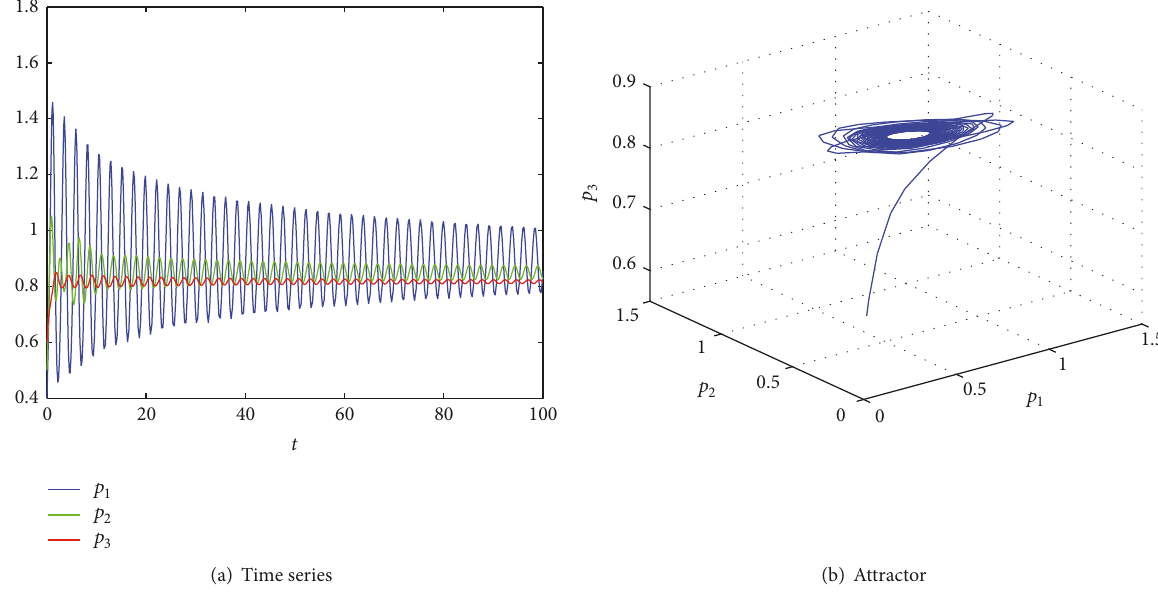
Figure 9: The time series and attractor when 𝜇 = 0.05 < 0.1055 .